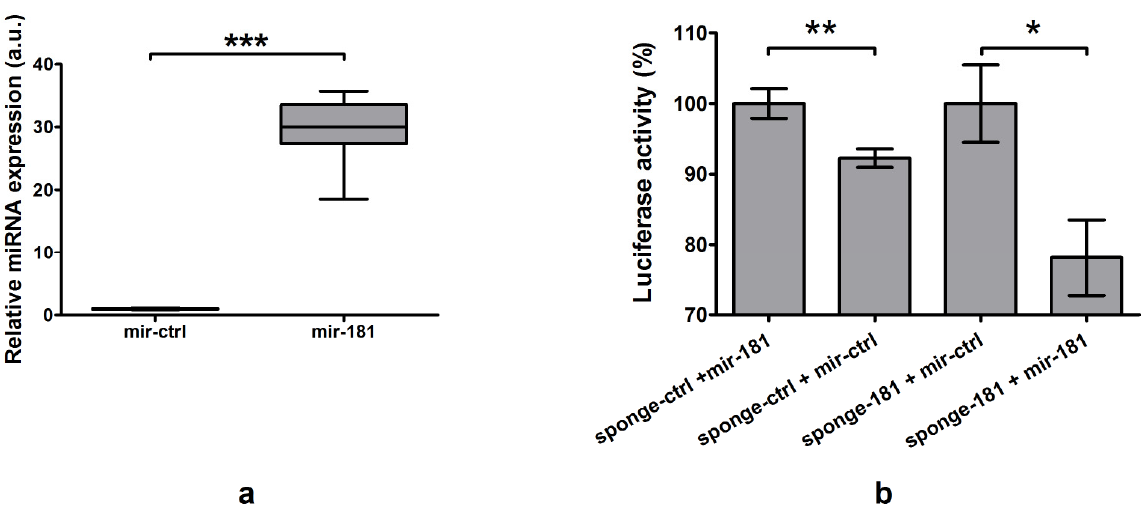
Figure 5. Functionality of obtained plasmids. ( a ) Transfection of HeLa cells with mir-181-expressing plasmid led to an increase in expression of miR-181a-5p measured in real-time PCR by 29-fold ( p < 0.0001). ( b ) Co-transfection of HeLa cells with sponge-ctrl plasmid and mir-ctrl led to a decrease in luminescence activity by 8% ( p = 0.004), when compared with co-transfection with sponge-ctrl and mir-181-expressing plasmids. Similarly, co-transfection with sponge-181 and mir-181 decreased luciferase activity by 22% ( p = 0.012), when compared with co-transfection with sponge-181 and mir-ctrl. Data are expressed as mean values +/ − SEM. Statistical analysis was performed using an unpaired t -test (* p < 0.05, ** p < 0.01, *** p < 0.001).